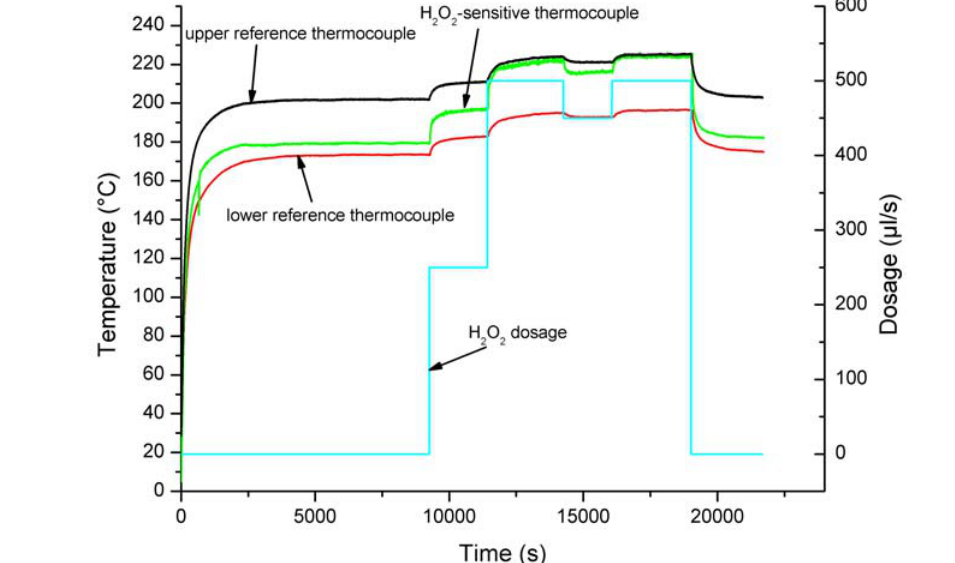
Figure 6. H O detection with the differential measurement set-up. 2 2